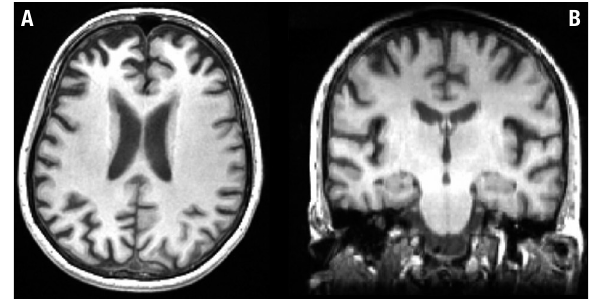
Figure 1. Brain MRI from patient TA, 48 year-old woman. [A] Axial slice: mild cortical frontal atrophy, predominant in medial regions. [B] Coronal slice: absence of hippocampal